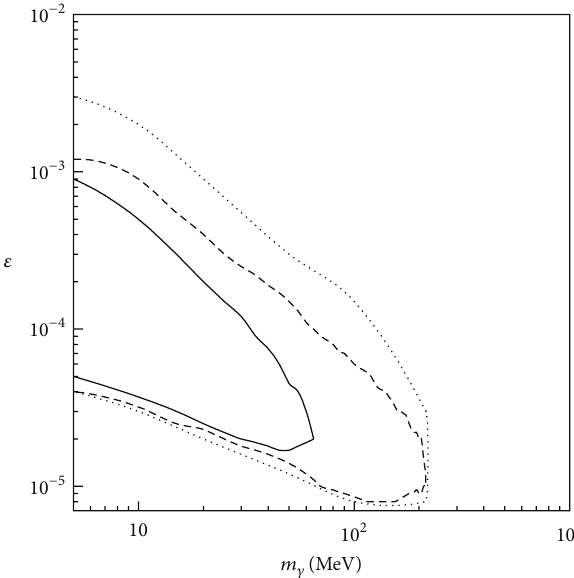
Figure 4: Explorable region for cases (a) solid, (b) dashed, and (c) dotted in the plane 𝜖 - 𝑚 𝛾 󸀠 . No instrumental backgrounds are taken into consideration, as well as potential efficiency and resolution effects for the detector. Above ∼ 210MeV, the opening of the 2-muon channel drastically reduces the effectiveness of the